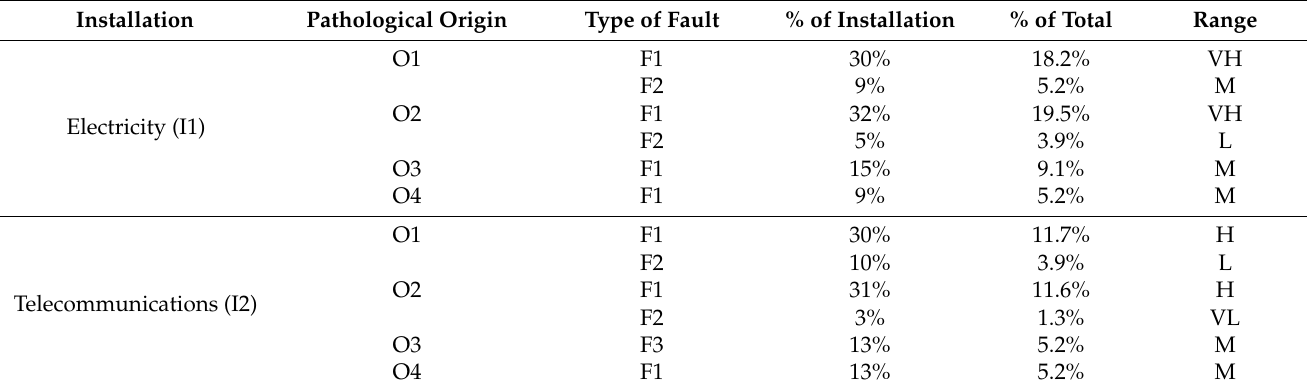
Table 4. Percentages of recurrence for each functional deterioration